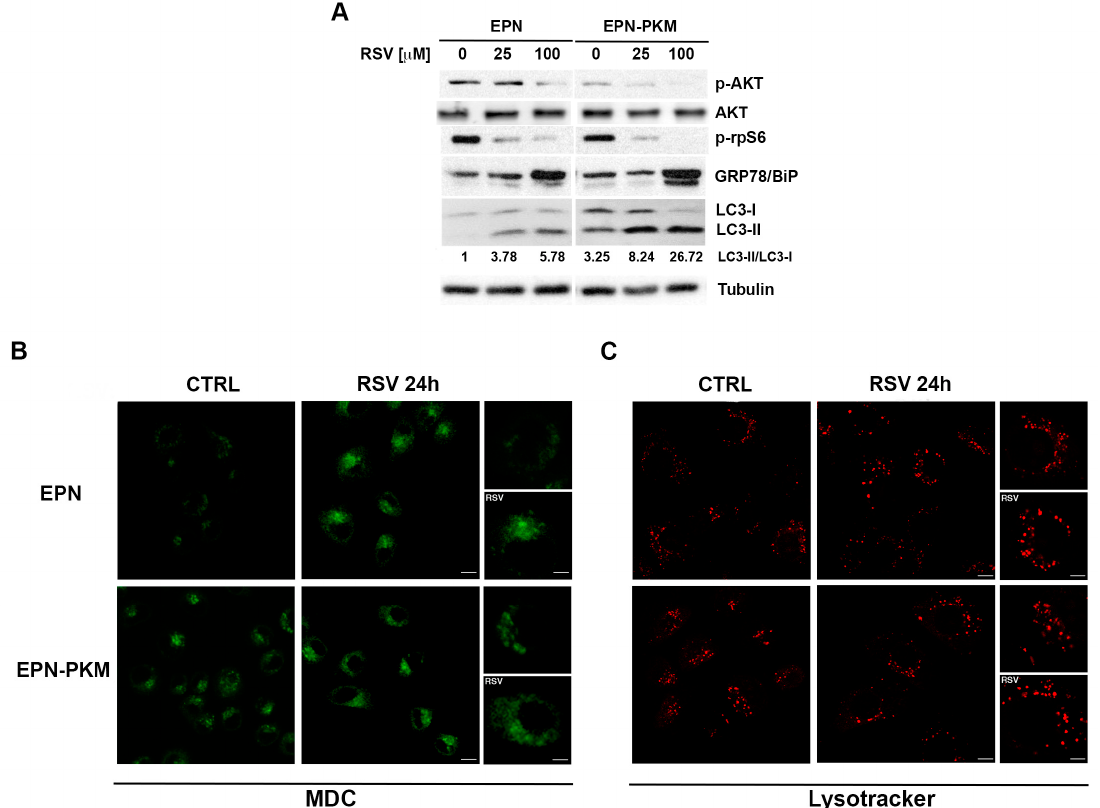
Figure 8. PYK2 and RSV affect autophagy in EPN and EPN-PKM cells: ( A ) Total cell lysates from EPN and EPN-PKM cells in control conditions or treated with 25 and 100 μ M RSV for 24 h were analyzed by Western blot using the indicated antibodies. Tubulin was used as loading control. The relative optical density of LC3-II/LC3-I ratio is shown; ( B , C ) EPN and EPN-KM cells, in control conditions (CTRL) or treated with RSV for 24 h were stained with monodansylcadaverin (MDC, in green, B ) or lysotracker (in red, C ) as described in materials and methods. Serial confocal sections were collected for each condition, pictures at higher magnification are shown. Bars, 10 μ m.